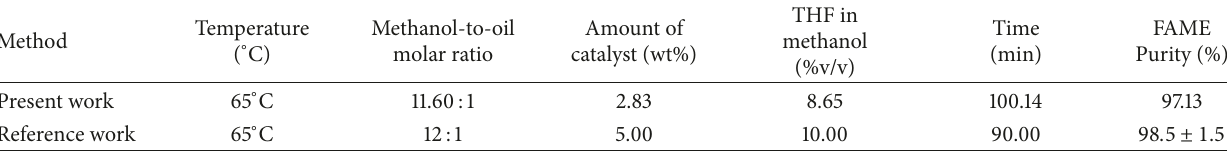
Table 7: Optimum condition of difference catalyst assisted with THF as cosolvent for biodiesel production.